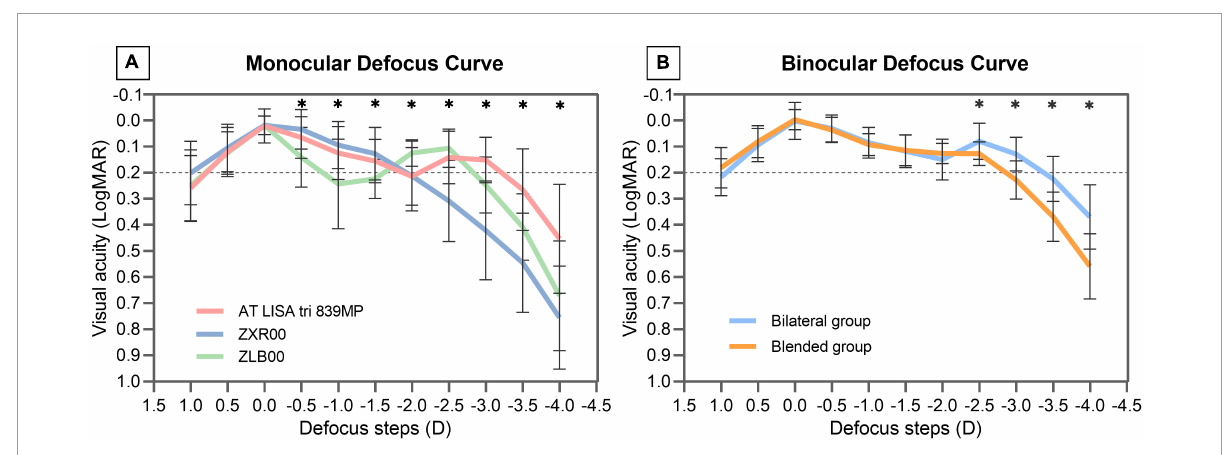
FIGURE5 Monocular defocus curves of eyes implanted with AT LISA tri 839MP, ZXR00, and ZLB00 IOLs (A) . Binocular defocus curves of patients in bilateral and blended groups (B) . LogMAR = logarithm of the minimum angle of resolution. Results are shown in logMAR notation, with reference to the 0.2 logMAR thresholds; ∗ Statistically significant difference between two